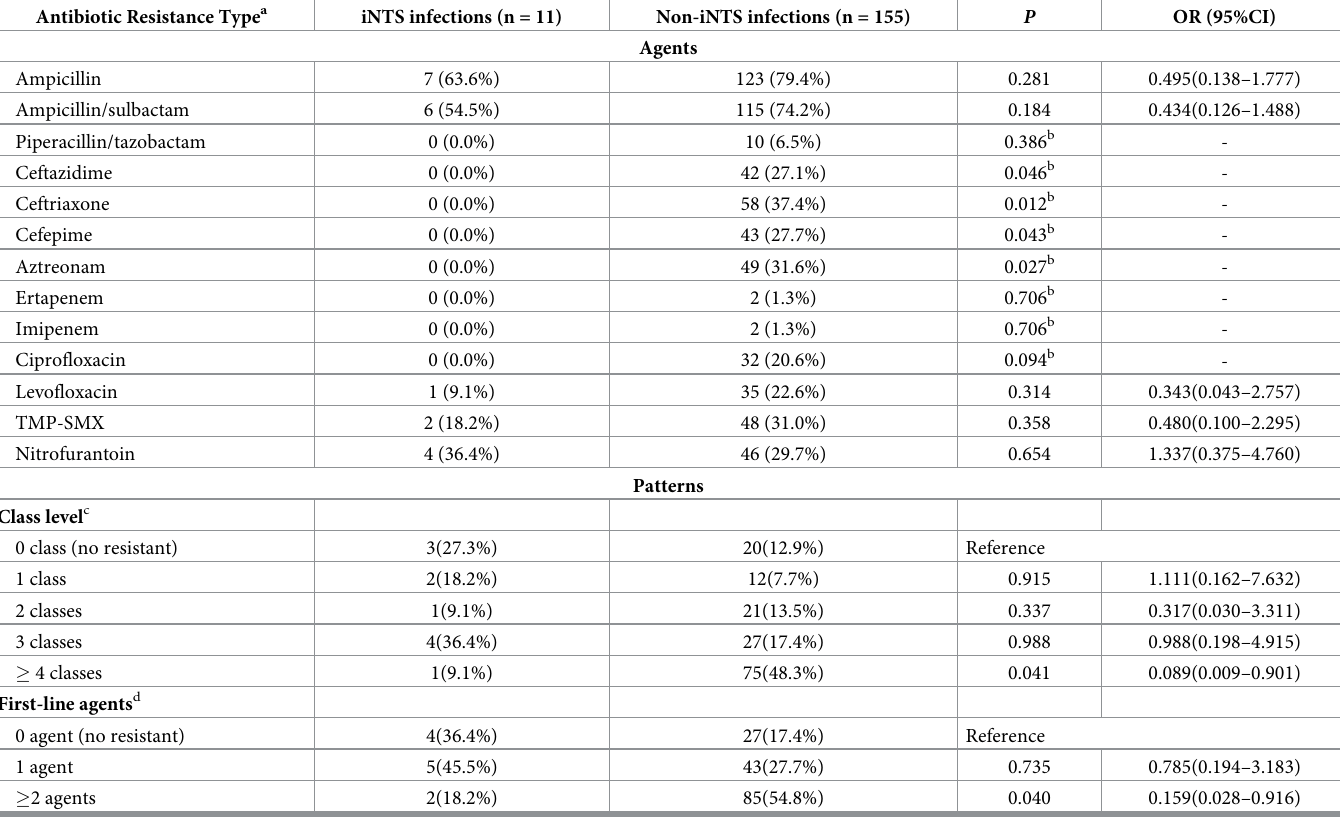
Table 3. Antibiotic resistance among iNTS and non-iNTS infections, Ningbo, China,